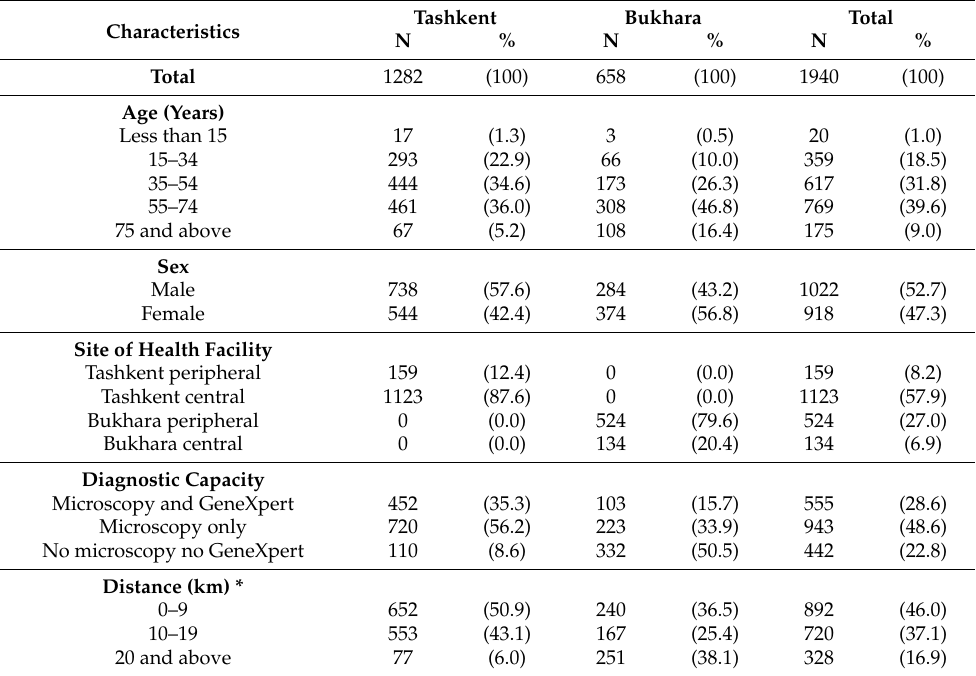
Table 3. Baseline characteristics of presumptive tuberculosis patients in selected health care facilities of Tashkent and Bukhara regions of Uzbekistan, January–March 2019.